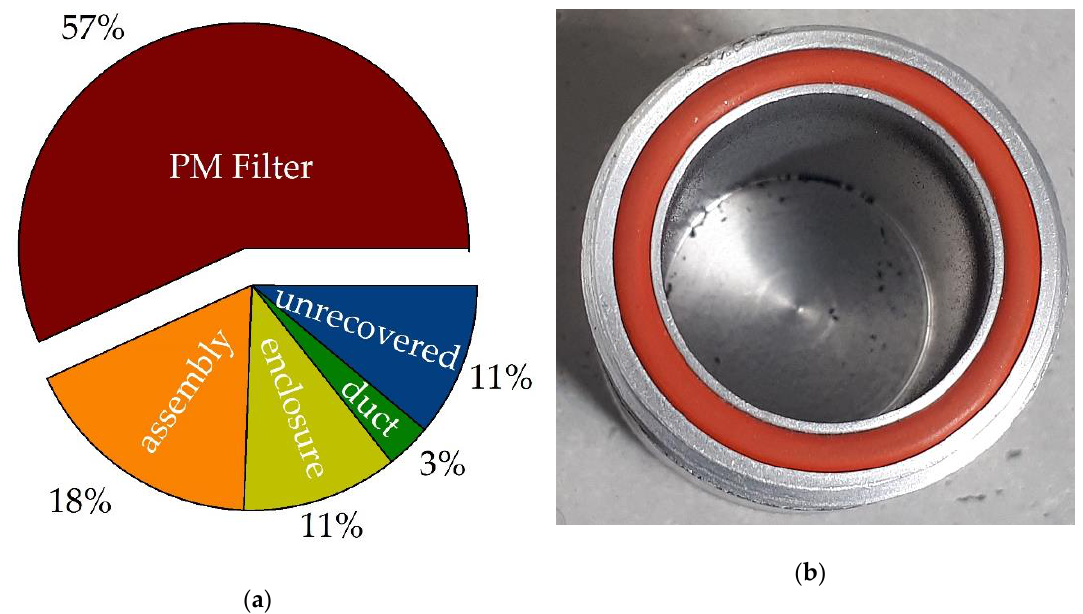
Figure 3. ( a ) Recovery of total PM emitted over a repetition of the WLTP cycle with ECE#2 brake pads; ( b ) photo of the 2.5 μm cyclone installed in front of the PM filter holder after three repetitions of WLTP segment 10.